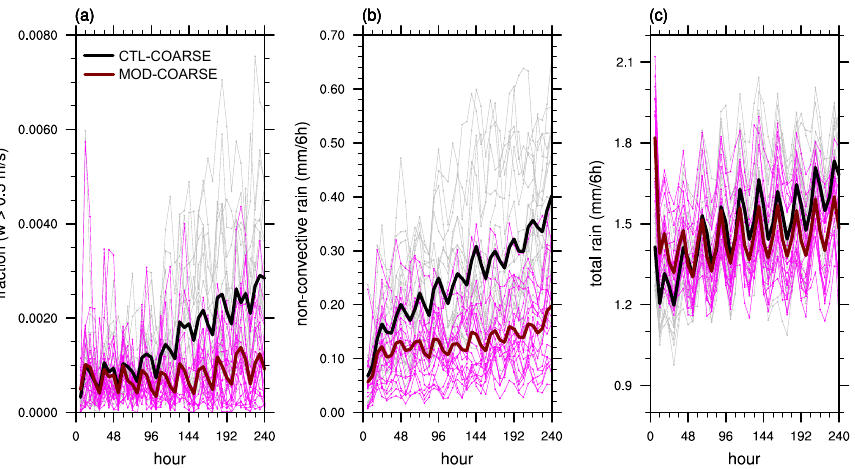
Figure 9. Time series of ( a ) the fraction of grid columns where the maximum vertical velocity is larger than 0.5 m s − 1 , ( b ) the six-hourly grid-scale precipitation rate, and ( c ) the six-hourly total precipitation rate averaged over the selected domain (100° E–160° W, 0–50° N) from the CTL-COARSE (black) and MOD-COARSE (brown) experiments. Thin and thick lines indicate individual and averaged results,